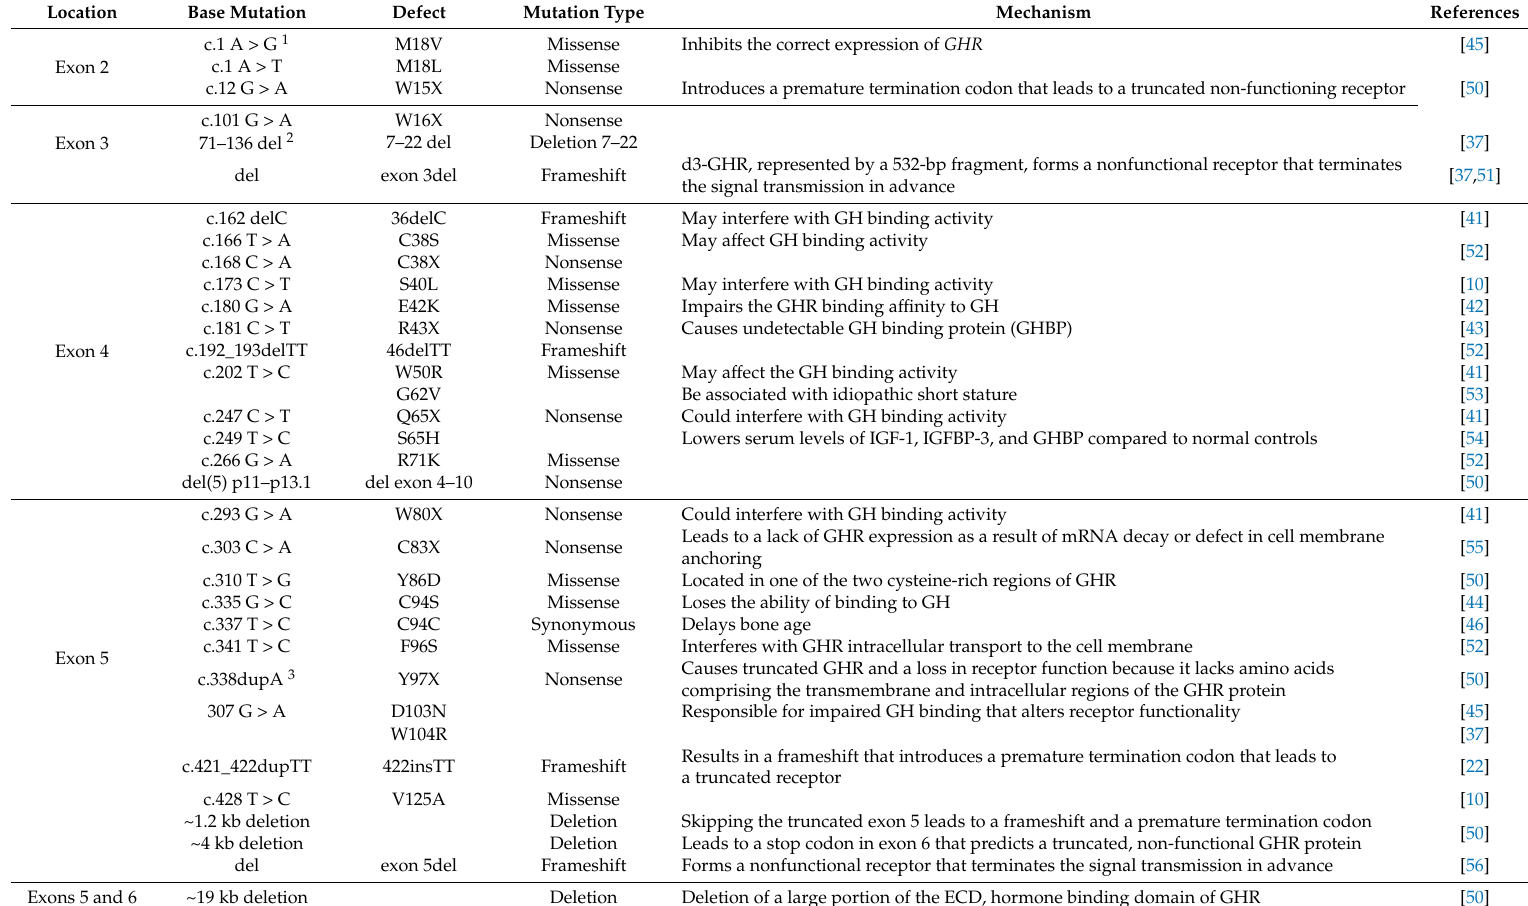
Table 1. Mutations in the extracellular domain (ECD) of GHR relevant to human dwarf mainly by interfering with GH–GHR